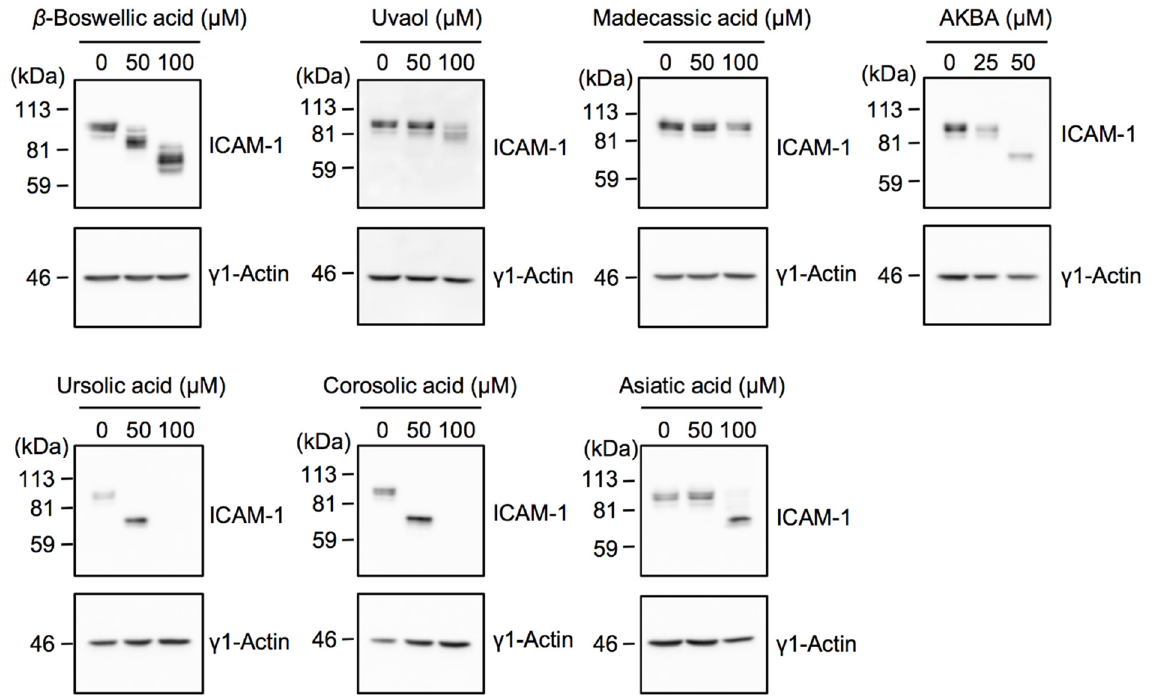
Figure 4. Effects of ursane-type pentacyclic triterpenoids on the glycosylation and expression of ICAM-1. A549 cells were preincubated with triterpenoids for 1 h and then incubated with IL-1 α (0.25 ng/mL) for 6 h in the presence of triterpenoids at the indicated concentrations. The ICAM-1 protein was evaluated by Western blotting. Blots are representative of at least three independent experiments.